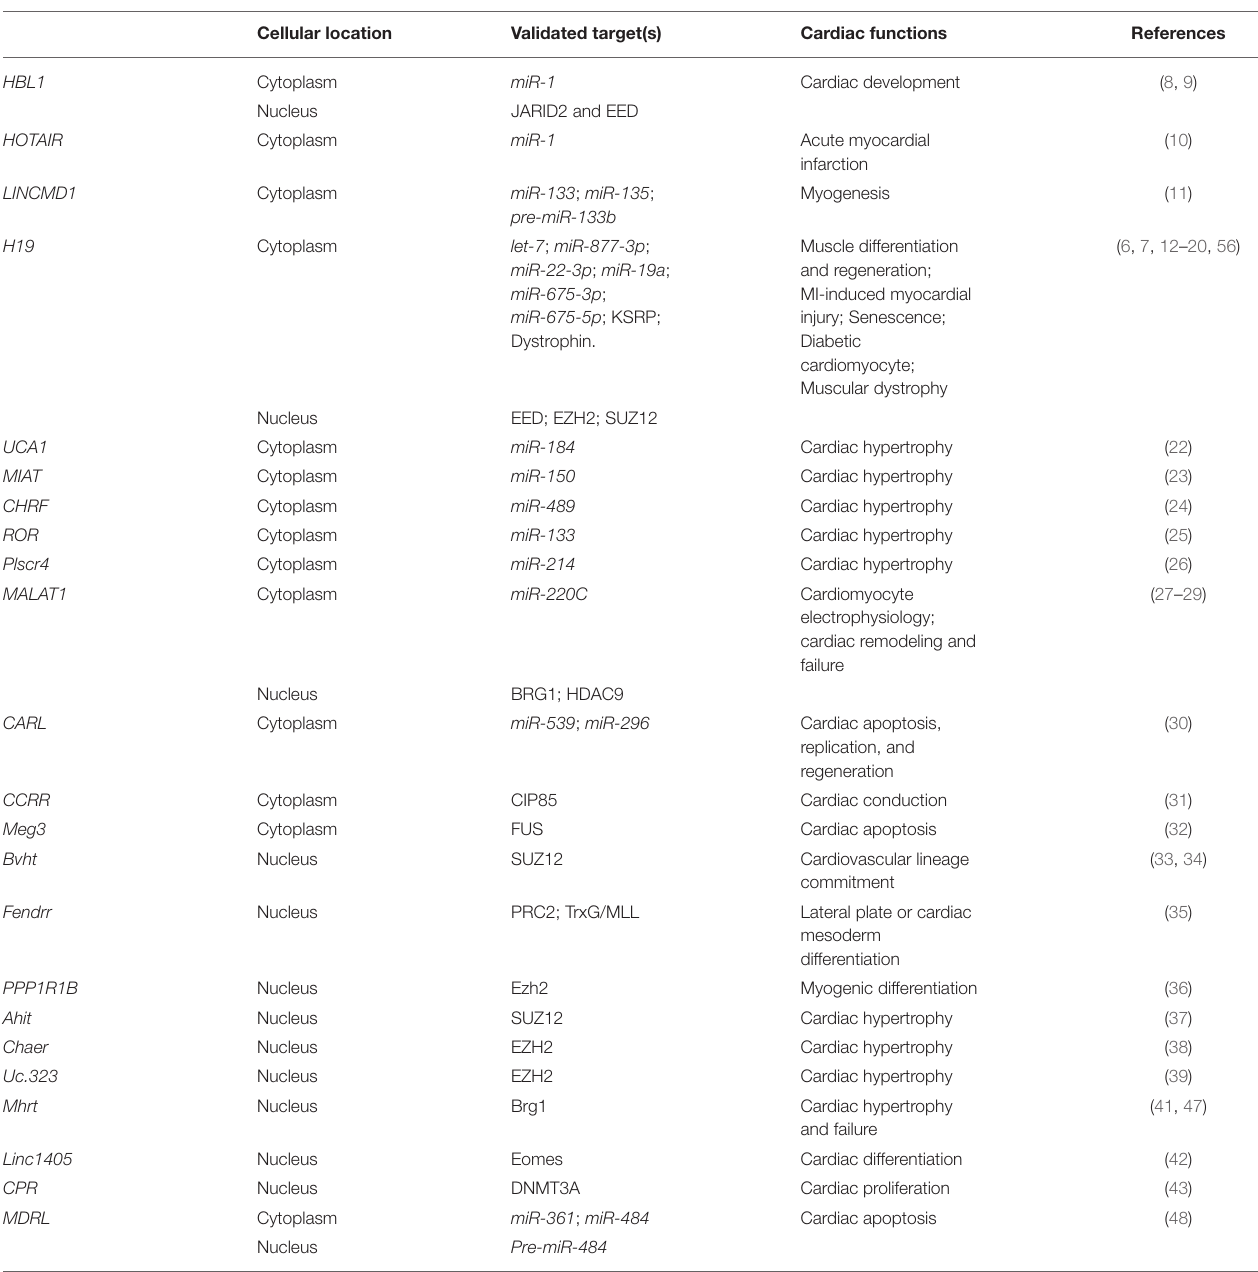
TABLE 1 | Roles of lncRNAs in heart development and